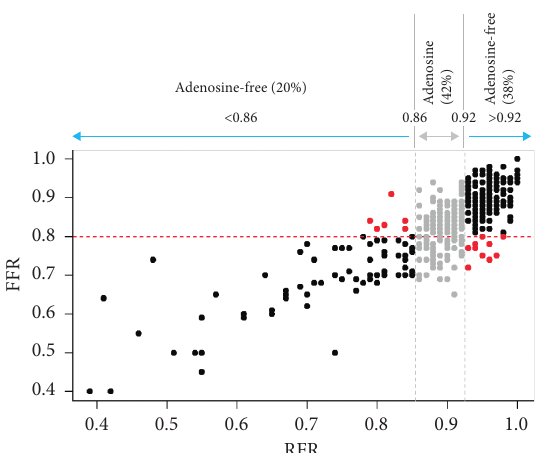
Figure 4: Comparison of the hybrid RFR-FFR strategy versus the exclusive FFR strategy for an agreement of at least 95%. The hybrid RFR-FFR strategy only misclassified 18 lesions (7 false positives and 11 false negatives), diminishing the percentage of lesions requiring the administration of vasodilators to 42% (158 lesions from a total of 380 lesions) compared to the exclusive FFR strategy. Red dots represent the disagreement and black dots represent the agreement between the two strategies. Grey dots should be reclassified by administration of vasodilators and determination of FFR. Two adenosine-free zones (blue) were established (RFR < 0.86 and RFR < 0.92). The adenosine zone (grey) falls between the RFR values of 0.86 and 0.92, with both